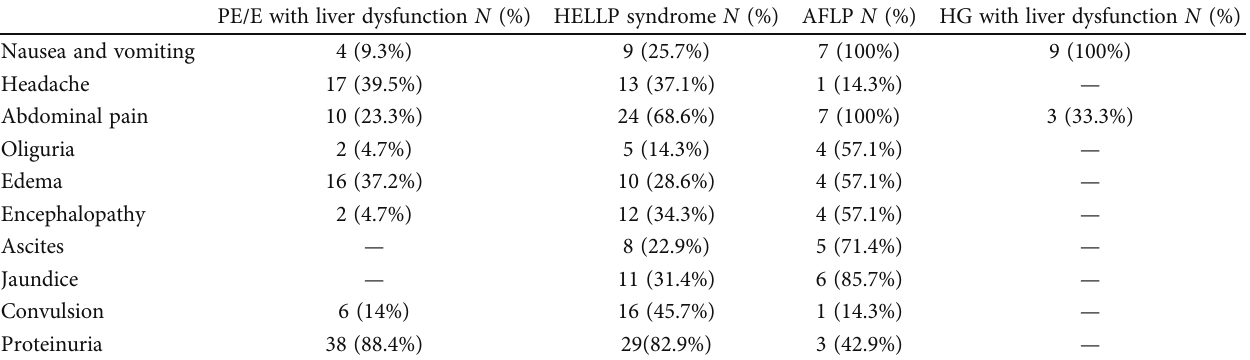
Table 2: Clinical manifestations of liver disease speci fi c to